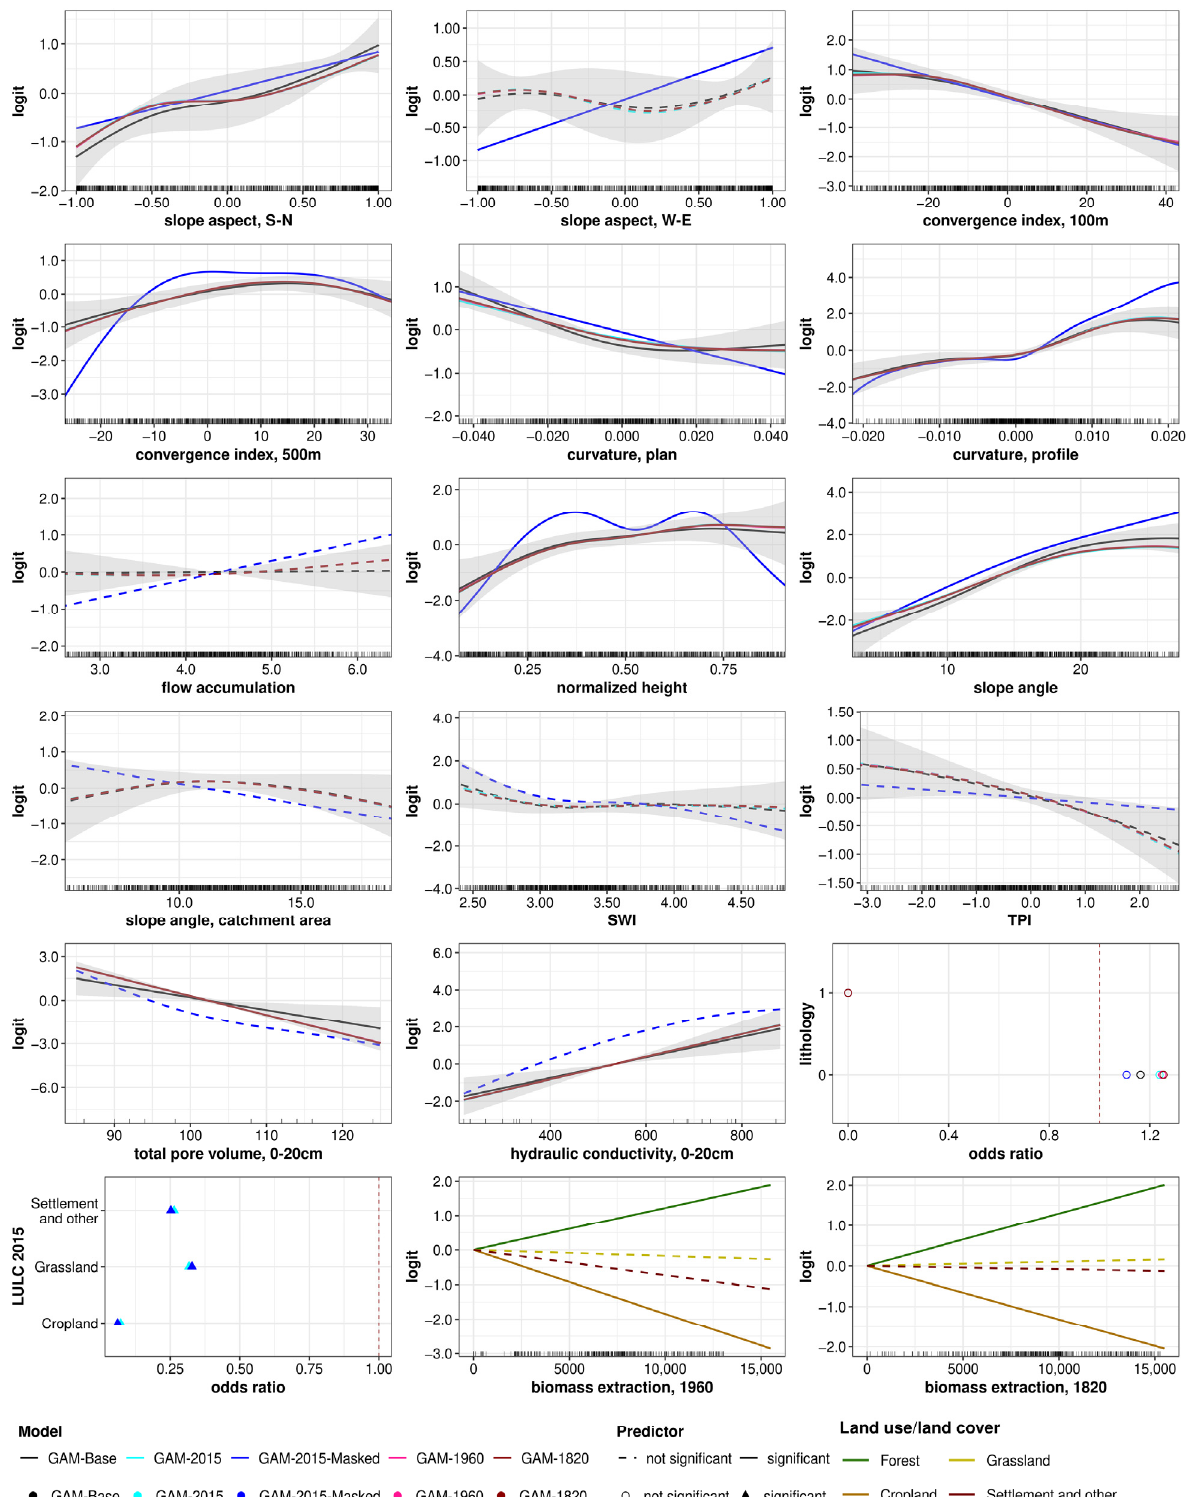
Figure A3. Predictor-response relationships of landslide models in Paldau. Grey: 95% Bayesian credible interval of GAM- Base. Reference level of LULC 2015: ‘Forest’; Lithological units: Reference: ‘Neogene formations with coarse-grained layers’, 0: ‘Neogene formations dominated by fine-grained sediments’, 1: ‘pre-Würmian Pleistocene formations’. Note: the y axes are plot-dependent, and the x axes of non-parametric transformation functions are limited to the 5th to 95th percentile range.